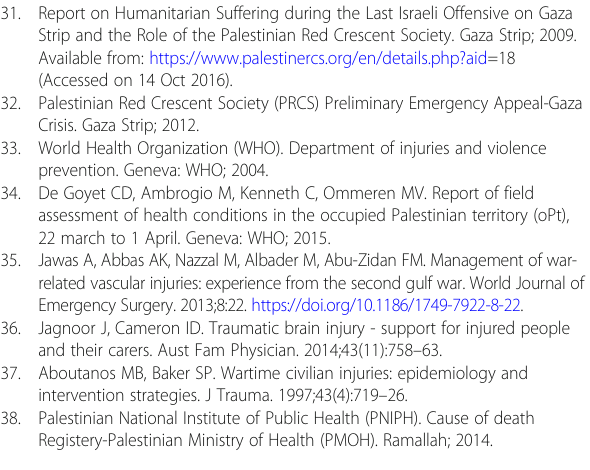
31. Report on Humanitarian Suffering during the Last Israeli Offensive on Gaza Strip and the Role of the Palestinian Red Crescent Society. Gaza Strip; 2009. Available from: https://www.palestinercs.org/en/details.php?aid=18 (Accessed on 14 Oct 2016). 32. Palestinian Red Crescent Society (PRCS) Preliminary Emergency Appeal-Gaza Crisis. Gaza Strip;